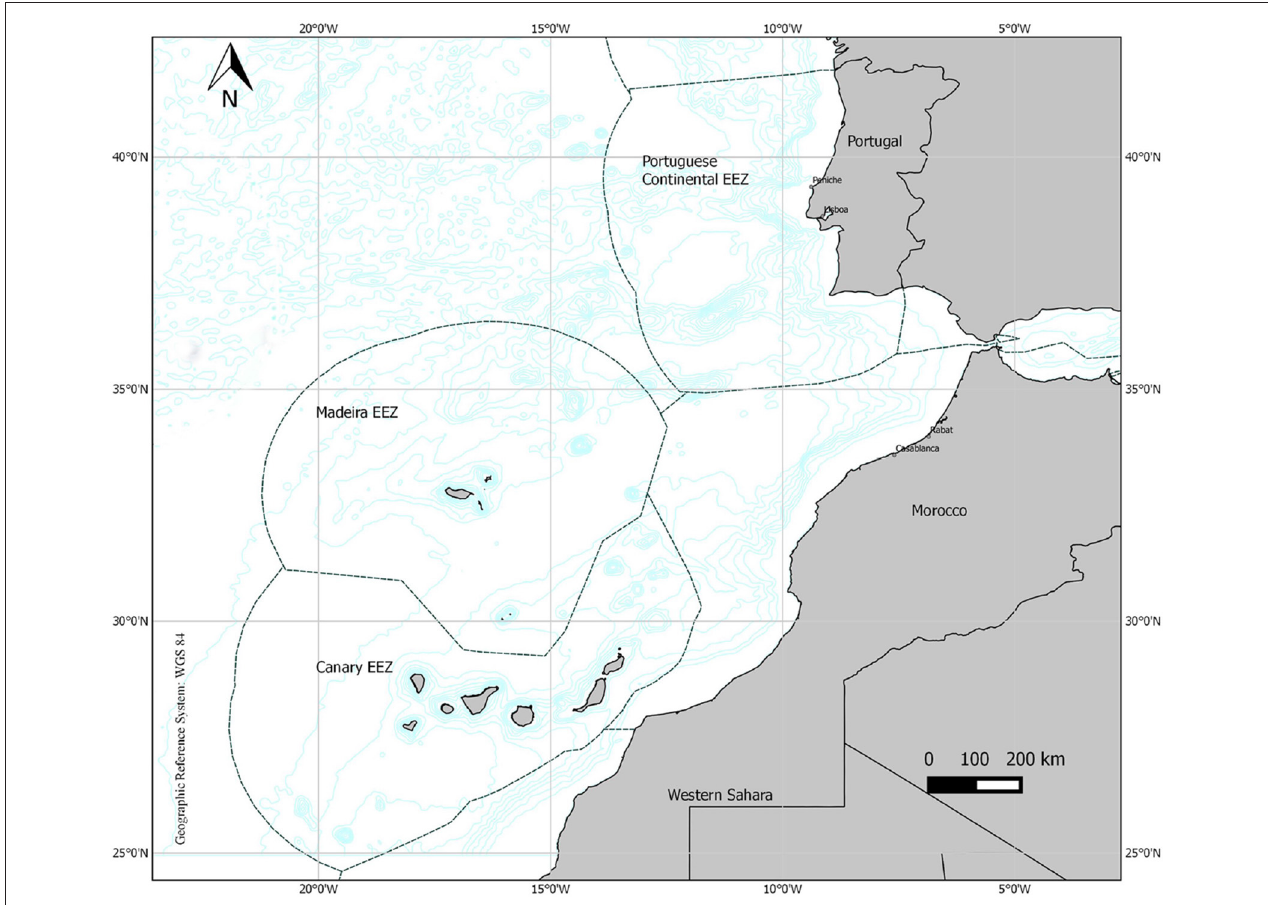
FIGURE 1 | Map showing the geographical areas where Trachurus picturatus was sampled off the north and central eastern Atlantic Ocean. The dashed lines indicate the limit of the exclusive economic zones (EEZs). Source: Regional Directorate of the